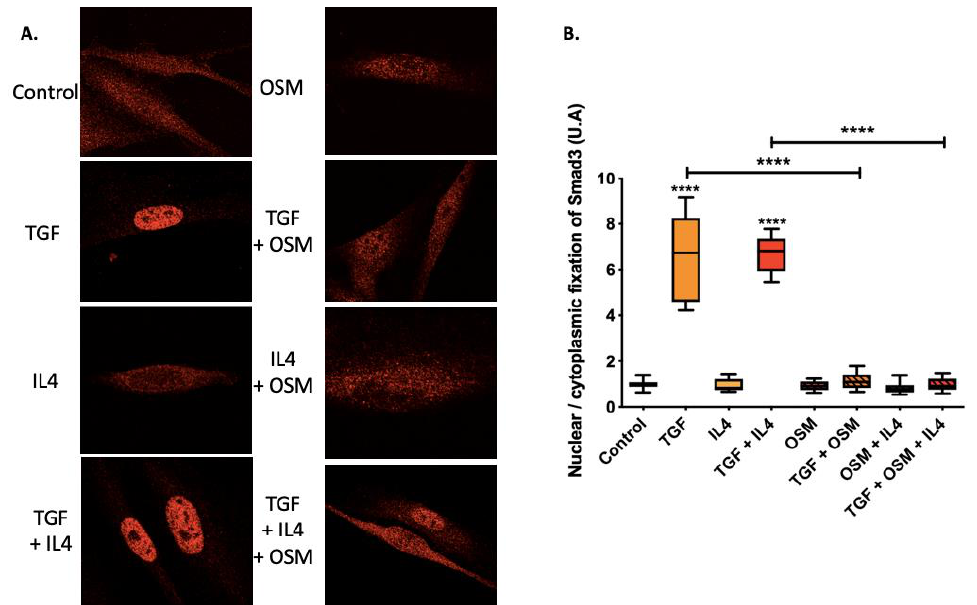
Figure 3. Nuclear/cytoplasmic localization of Smad3 in nasal-polyp-derived fibroblasts cultured with TGF- β1 and/or IL -4 and/or OSM was analyzed under confocal microscopy. Pictures are representative of three independent experiments. **** p < 0.0001.